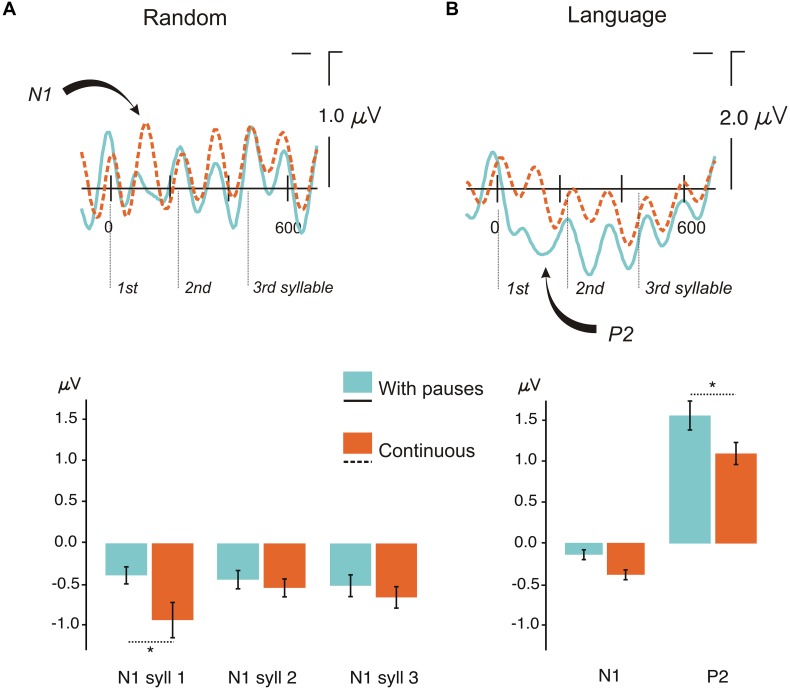
Event-related potentials (ERP) results for the conditions continuous and with pauses. (A) Top: Grand Average ERPs for each trisyllabic presentation for random streams in the continuous condition and the condition with pauses at the ROI (average of F3, F4, C3, C4 electrodes) analyzed in the serial t-test analysis with a baseline from -100 ms to stimulus onset. Bottom: Mean peak-to-peak differences from the previous positive peak to the N1 peak amplitude for each syllable in the random condition with pauses and continuous. Bars indicate standard error of the mean (SEM). (B) Top: Grand Average ERPs for each trisyllabic word for language streams in the continuous condition and the condition with pauses at the ROI (average of F3, F4, C3, C4 electrodes) analyzed in the serial t-test analysis with a baseline from -100 ms to stimulus onset. Bottom: Mean peak-to-peak differences from the previous positive peak to the N1 peak amplitude and from the first negative peak in the epoch to the peak amplitude of the P2 component in the language condition with pauses and continuous. Bars indicate SEM. ∗P < 0.05.